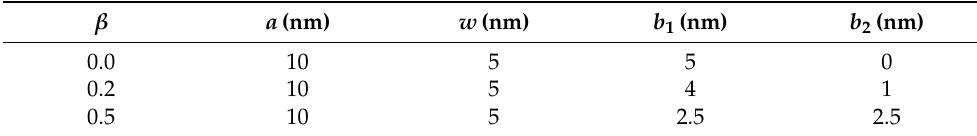
Table 1. Geometric parameters for different values of β